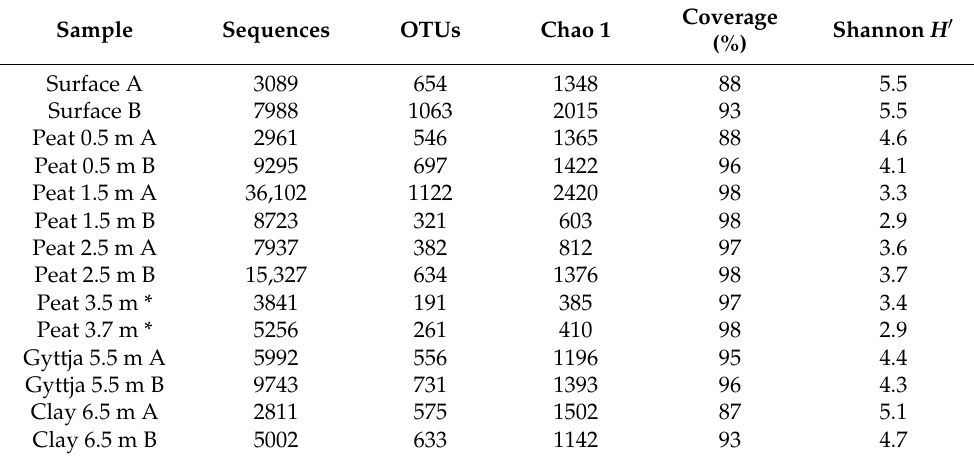
Table 6. Obtained number of bacterial 16S rRNA gene sequence reads (Sequences), observed (OTUs) and estimated (Chao1) number of bacterial OTUs, Good’s OTU coverage (%) estimated from the Chao1 (Coverage), and diversity index (Shannon) of the communities. The data were rarefied to 2000 sequences for calculating the number of OTUs, Shannon index, Chao1 estimate, and Good’s coverage. The coverage describes the percentage of OTUs detected from the rarefied data set compared to the Chao1 estimated number of OTUs determined from the rarefied data. Samples A and B are the duplicate samples from the same layer and the DNA was extracted using Extraction Buffer SL1 and SL2 for sample A and B, respectively.